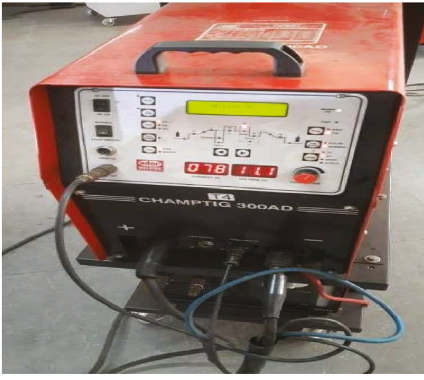
Figure 2: TIG welding setup.